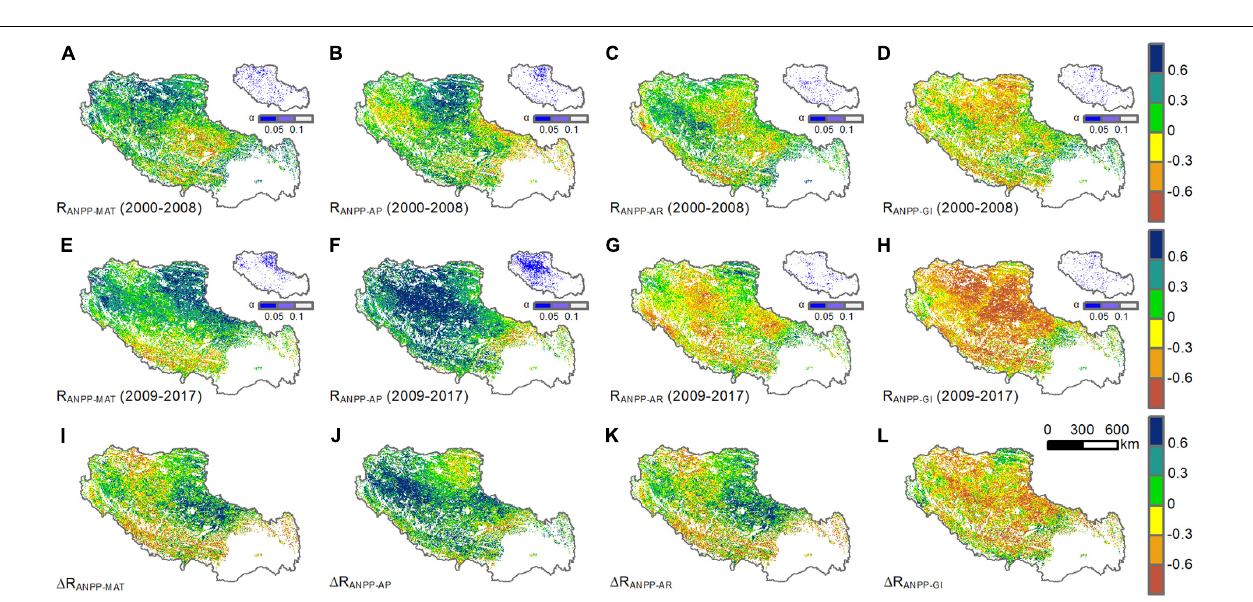
FIGURE 6 | The (A) mean and (B) trend of grassland ANPP in the two subperiods, before (2000–2008) and after (2009–2017) staring the “Ecological Security Barrier Protection and Construction Project” for each grassland type in Tibet.